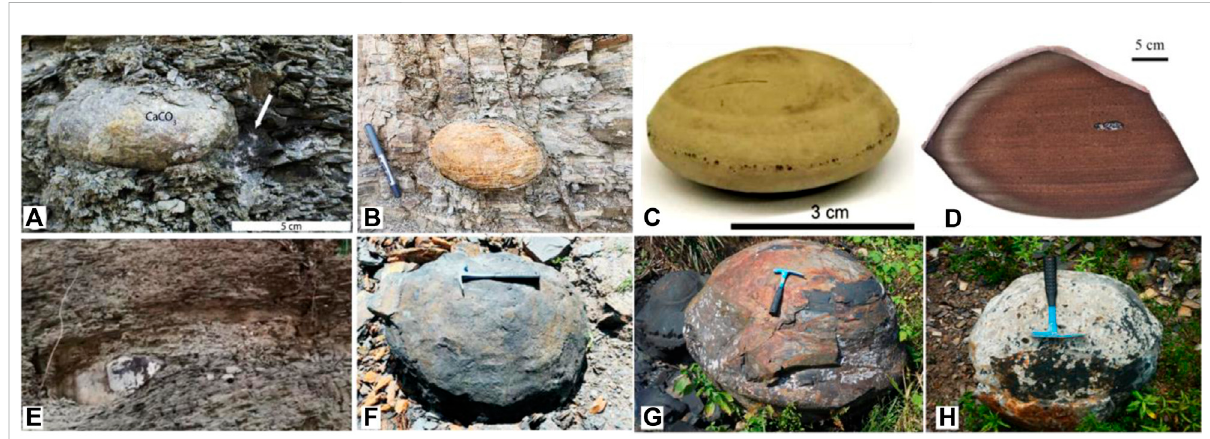
FIGURE 1 Carbonateconcretionsinshales. (A) CarbonateconcretionsinHanovershalesinNewYork,theUnitedStates.Carbonateconcretionwithbarite (white arrow) fi lling a pressure shadow (Lash, 2015); (B) Carbonate concretions in Cretaceous Nenjiang shales in the Songliao Basin, China; (C) Carbonate concretions in Pleistocene mudstones in Connecticut, the United States (Wu et al., 2021); (D) Carbonate concretions in the Toarcian Posidonia shales in southwestern Germany (Plet et al., 2016); (E) Carbonate concretions in Shanxi-Taiyuan shales in Jiaozuo City, China; (F) CarbonateconcretionsinYanchangshalesintheOrdosBasin,China(Dongetal.,2017); (G,H) CarbonateconcretionsinCambrianNiutitangshalesin Chongqing,